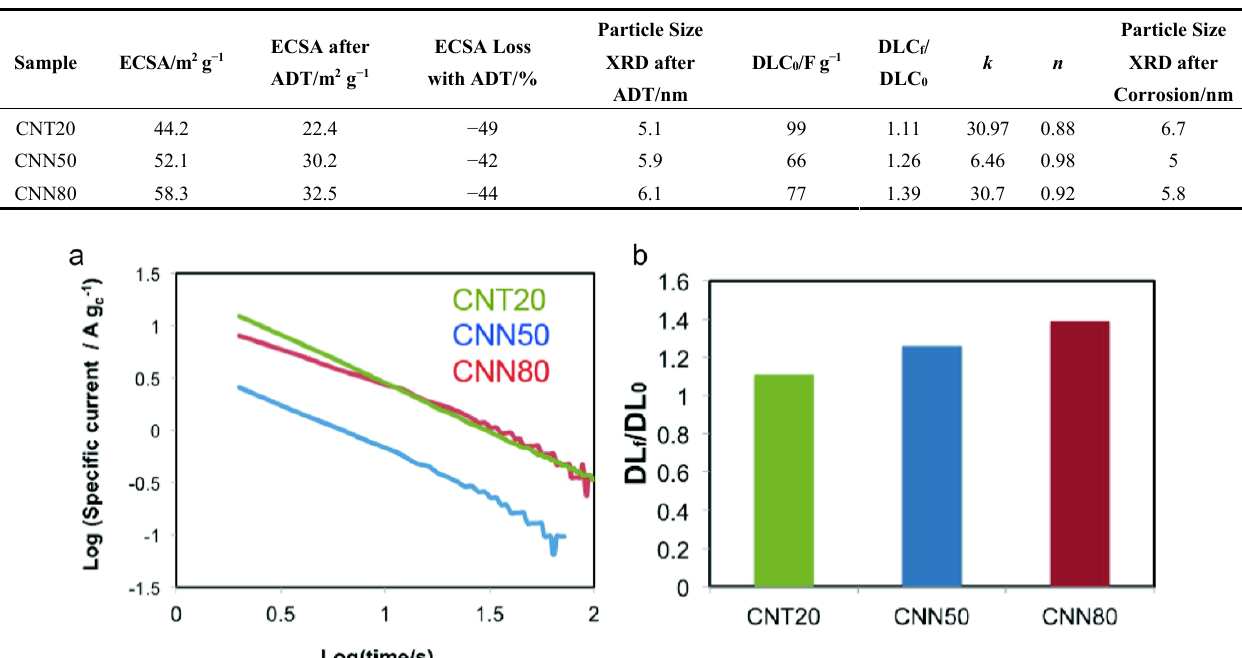
Table 3. ECSA before and after ADT, particle size measured from XRD after ADT and corrosion test, DLC, DLC after over before corrosion, carbon corrosion parameters.